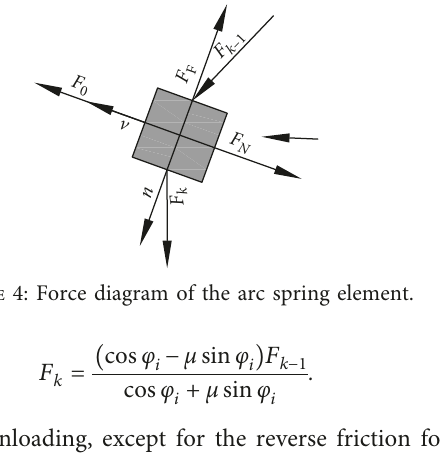
Figure 4: Force diagram of the arc spring